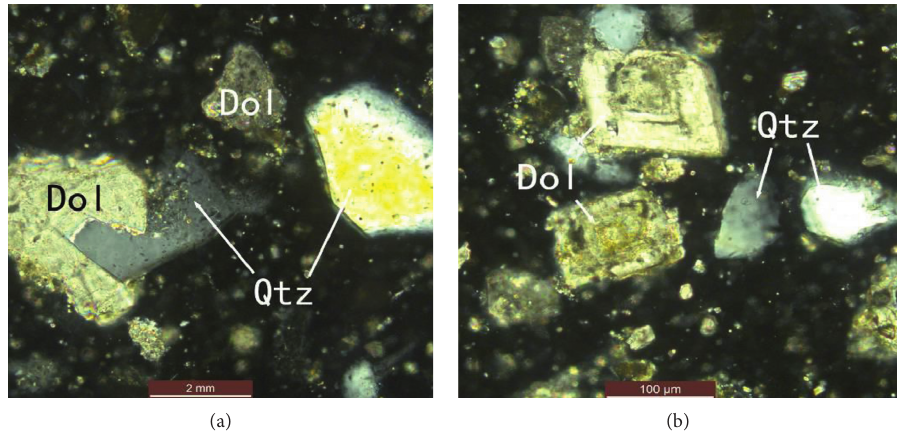
Figure 8: Embedded characteristics of Quartz (TCPL represents transmitted crossed polarized light). (a) Quartz (Qtz) and dolomite connected, TCPL. (b) Clastic angular quartz (Qtz),